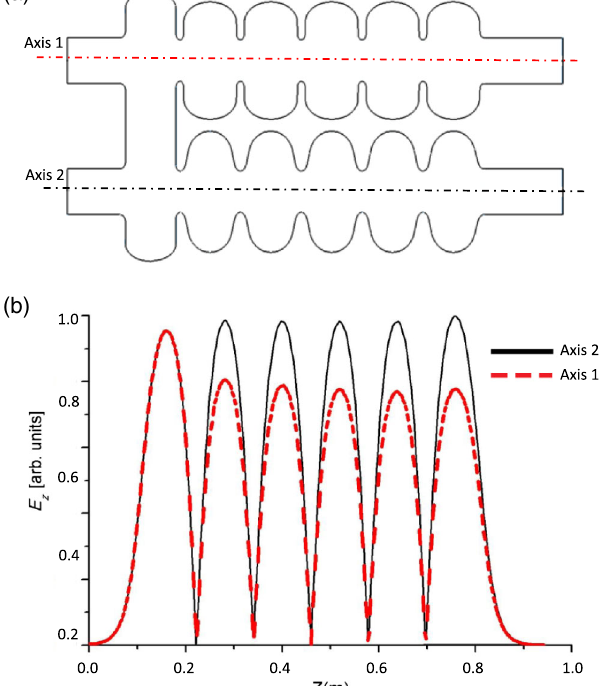
FIG. 3. (a) A schematic of the dual-axis asymmetric cavity constructed with the T (axis 2) and L (axis 1) cells connected by the racetrack bridge cell (T and L configuration). (b) The dependence of the absolute value of the accelerating field ( E z ) along the longitudinal coordinate z on both axes.